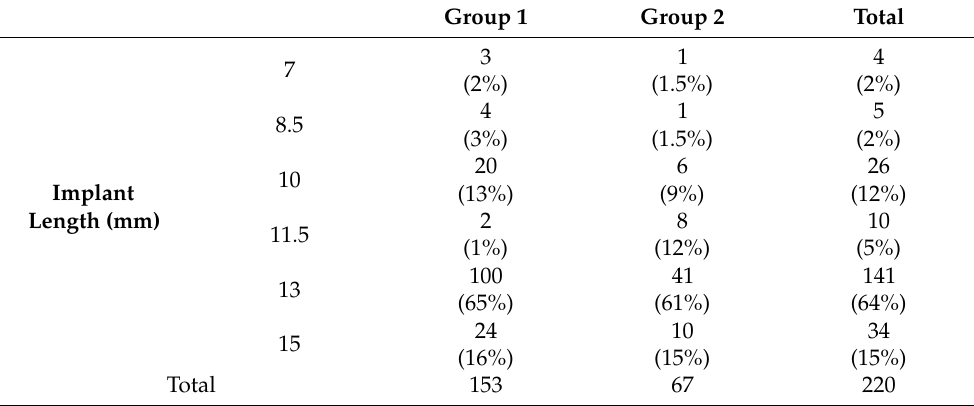
Table 1. Distribution of implant length in Group 1 (EA ≥ 30 ◦ ) and Group 2 (EA < 30 ◦